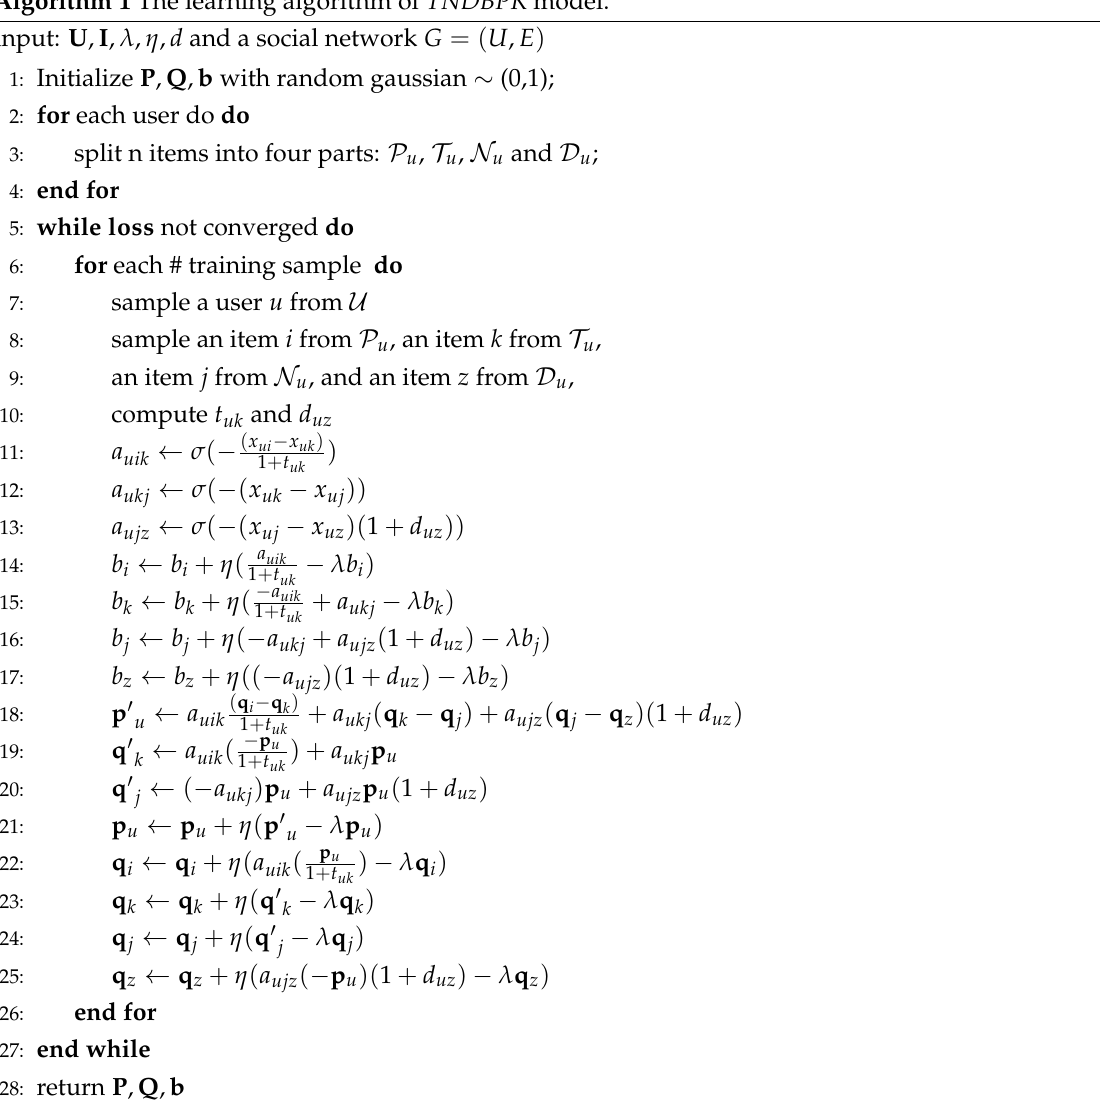
Algorithm 1 The learning algorithm of TNDBPR